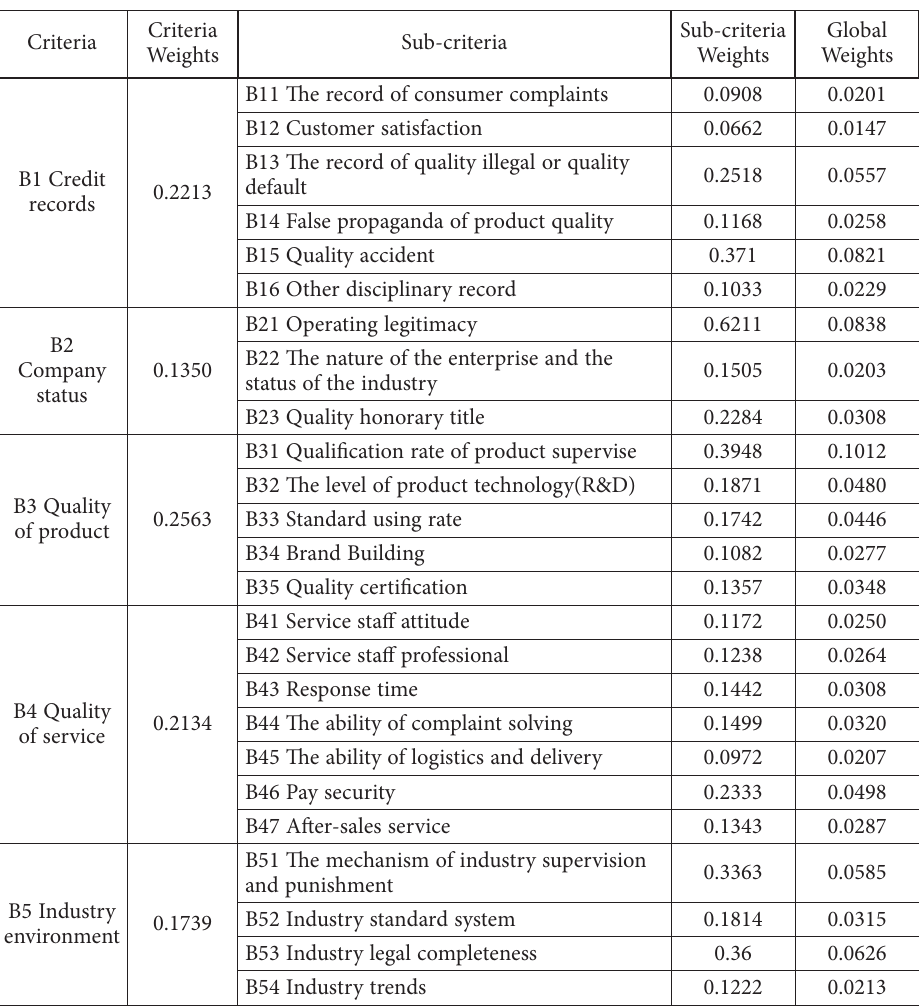
Table 11. Quality credit evaluation